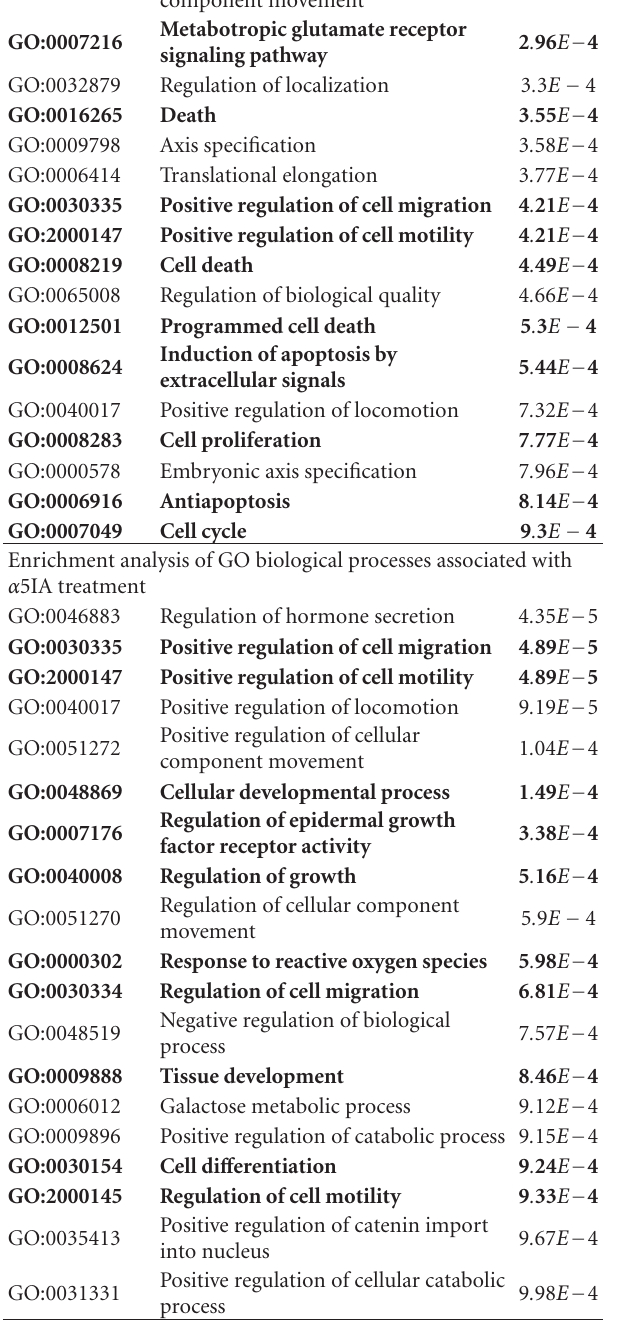
Euploids miceEuploids mice Ts65Dn